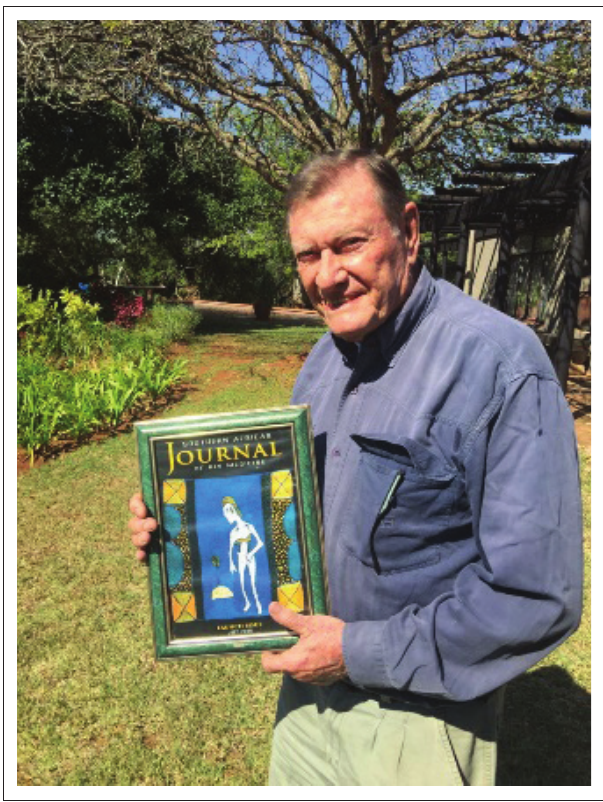
FIGURE 1: Prof. Des Martin, Founding Editor of the Southern African Journal of HIV Medicine, May 2021, with his framed copy of the first